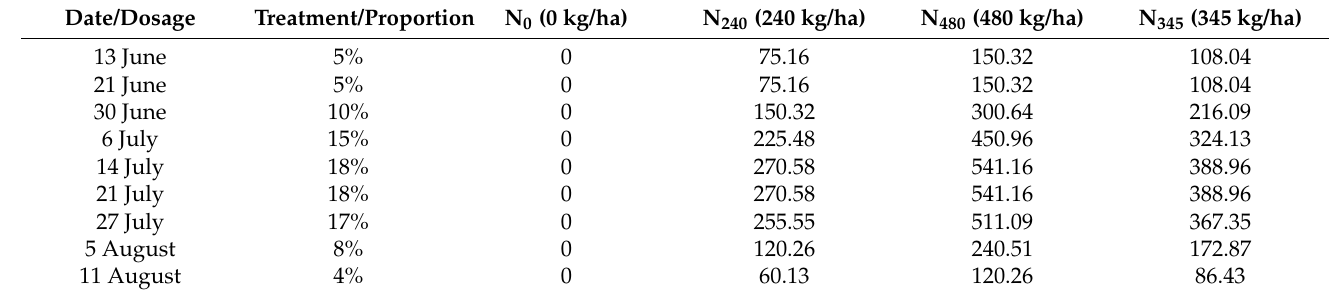
Table 1. Time, proportion, and amount of nitrogen application for each treatment in the test plot in